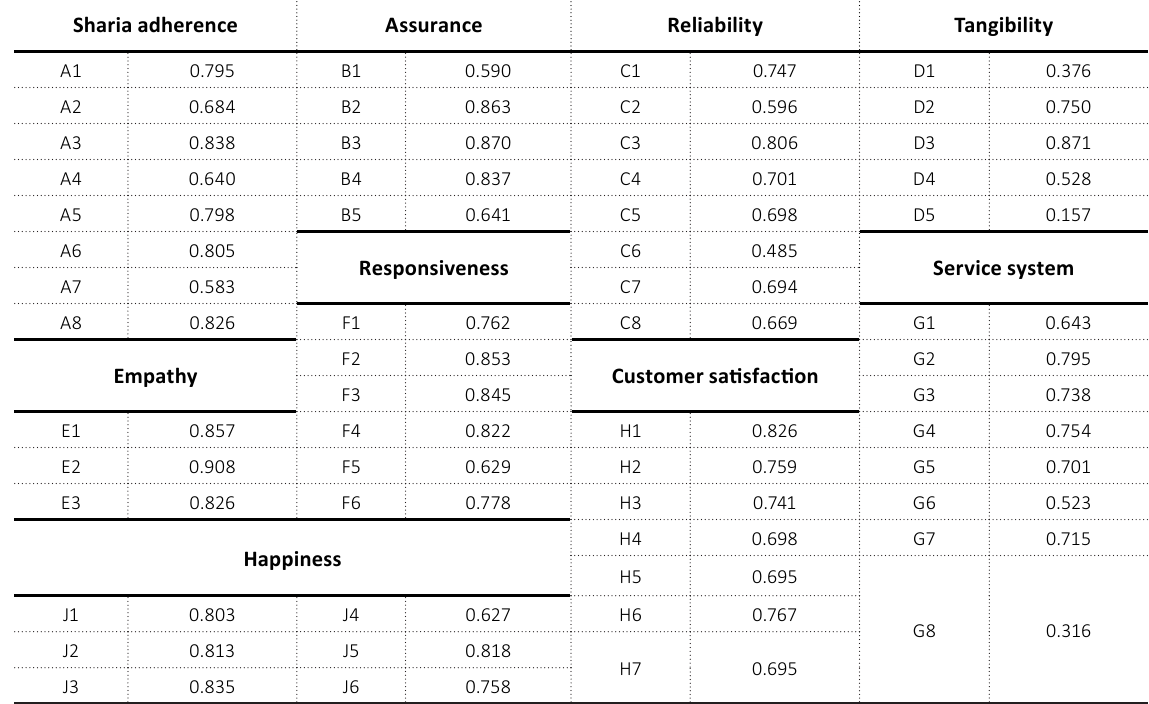
Table 1. The results of the first convergent validity test Sharia adherence Assurance Reliability